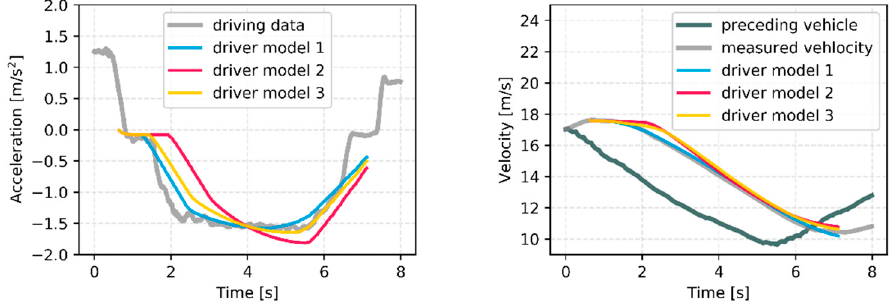
Figure 9. Deceleration planning results according to the individual driver.